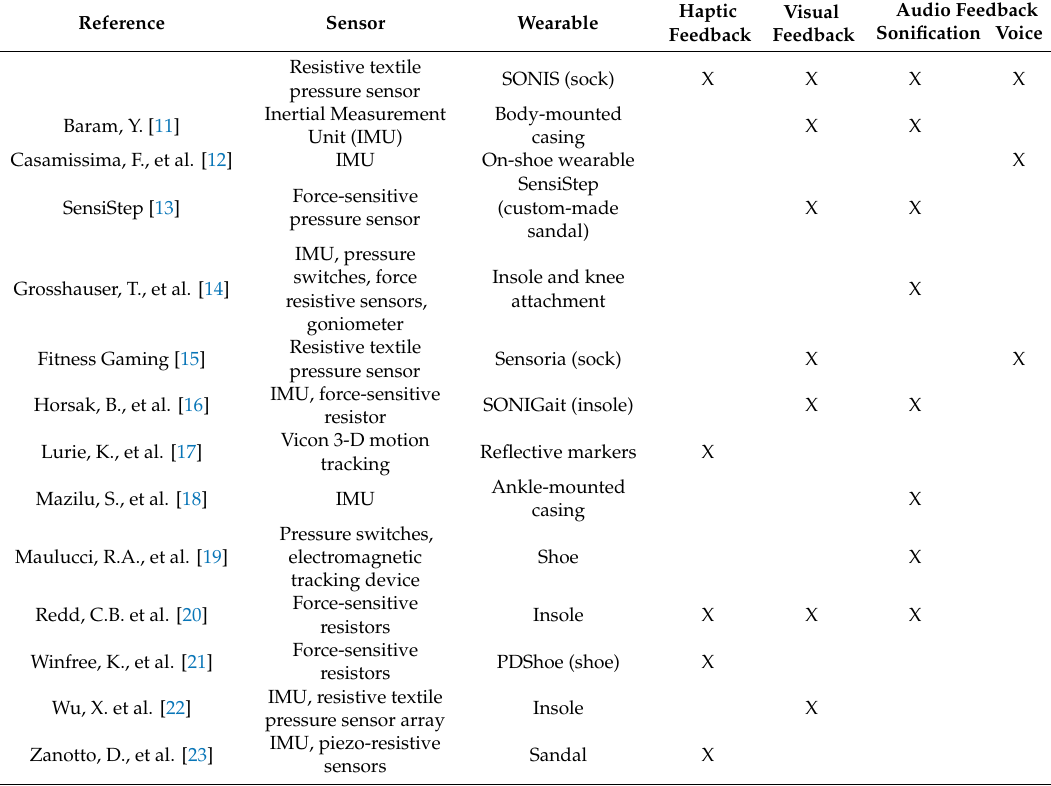
Table 1. An overview of biofeedback applications for gait retraining and the feedback modalities they use, and a comparison with